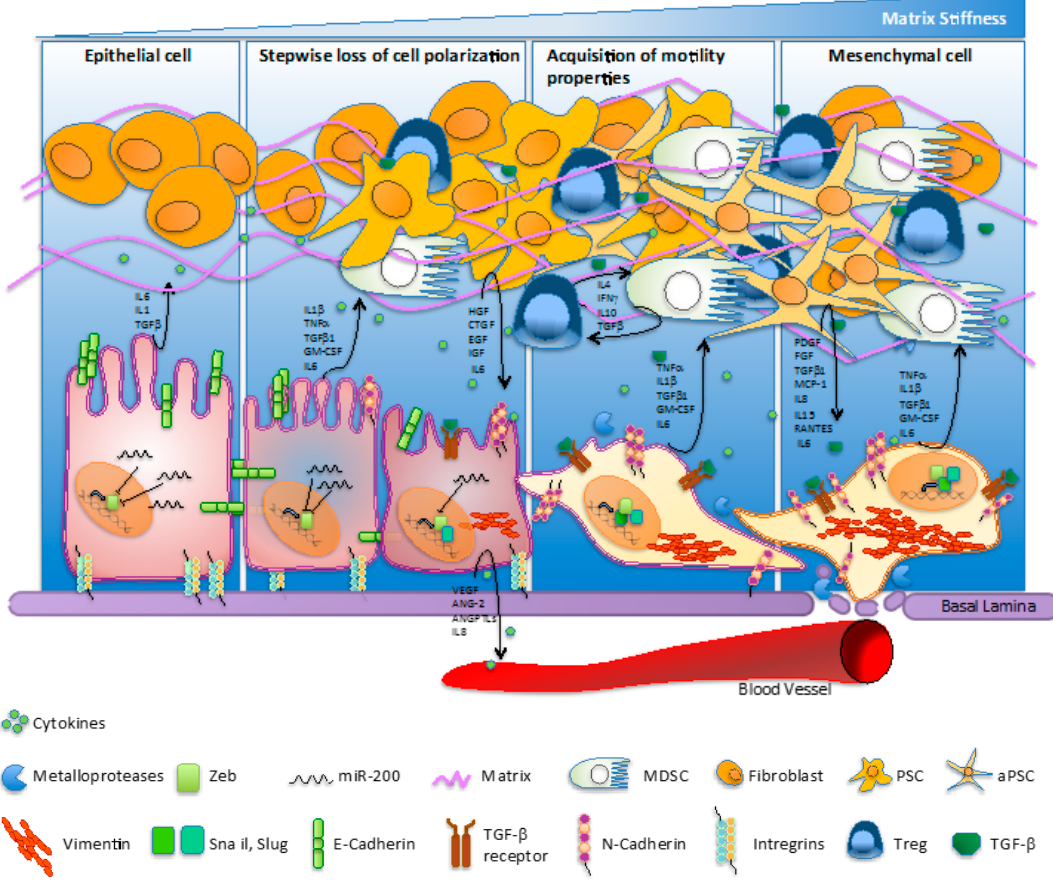
Figure 1. Molecular hallmarks/fluctuations/switching regulating the epithelial-to-mesenchymal transition (EMT) process in pancreatic cancer. The EMT process involves loss of cell polarization, a gain in migratory abilities and progressive acquisition of a mesenchymal phenotype. The EMT mechanism is characterized by the ‘cadherin switch’, where E-cadherin expression is progressively downregulated and replaced by the expression of N-cadherin. The transition process is associated to a decrease of miR-200 levels and an increase of classical E-cadherin transcriptional suppressors—such as ZEB1, Snail, and Slug—activated upstream by TGF- β . Cells undergoing EMT commonly quit the expression of extracellular matrix (ECM) elements mediating structural rigidity and cell adhesion in favor of proteases, cytokines, growth factors, and ECM components which improve cell migration and intravasation in bloodstream. Pancreatic cancer cell cytokines accelerate transformation of fibroblasts into quiescent pancreatic stellate cells (PSCs) and then into activated pancreatic stellate cells (aPSCs). Furthermore, inflammatory cytokines recruit myeloid progenitor cells and mediate their subsequent differentiation into myeloid-derived suppressive cells (MDSCs), which suppress the immune surveillance function. IL: interleukin; TGF: transforming growth factor; TNF: tumor necrosis factor; GM-CSF: granulocyte-macrophage colony-stimulating factor; HGF: hepatocyte growth factor; CTGF: connective tissue growth factor; EGF: epidermal growth factor; IFN: interferon;